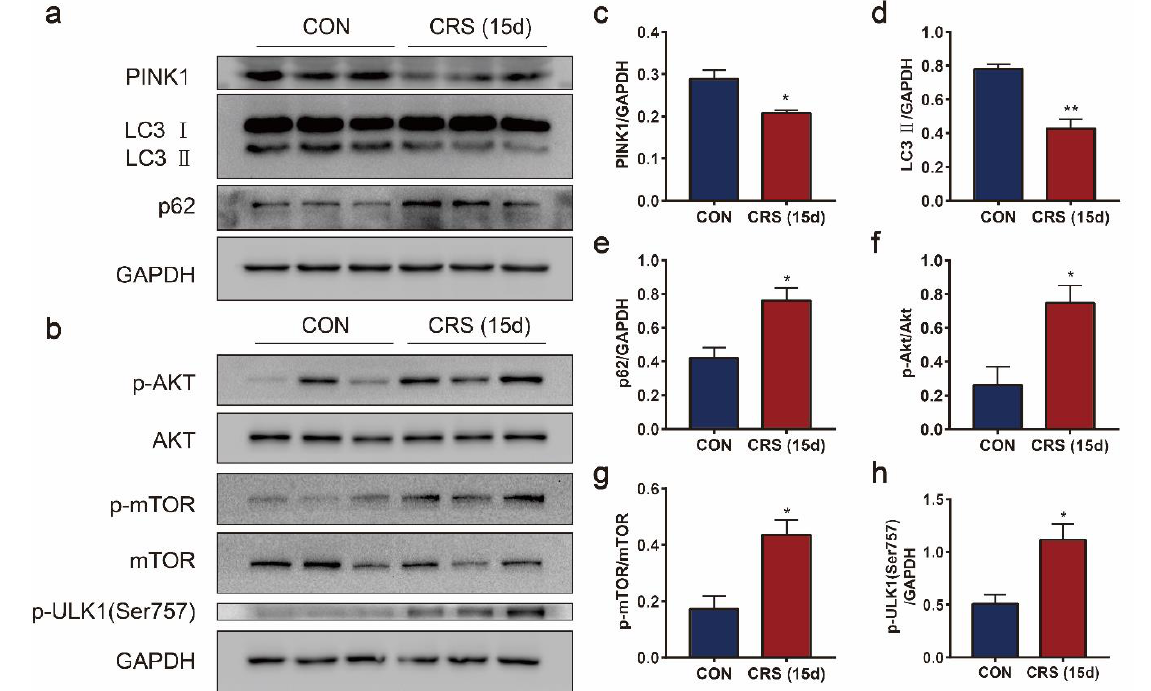
Figure 7. Effects of CRS on mitophagy in the gastrocnemius muscle. Immunoblotting of PINK1, LC3, and p62 in the gastrocnemius muscle ( a ). Immunoblotting of p-AKT, AKT, p-mTOR, mTOR, and p-ULK1 (Ser757) in the gastrocnemius muscle ( b ). Quantification of PINK1 ( c ), LC3-II ( d ), p62 ( e ), p-AKT/AKT ( f ), p-mTOR/mTOR ( g ), and p-ULK1 (Ser757) ( h ) protein abundance. Data are presented as the mean ± SEM (n = 3), * p < 0.05, ** p < 0.01.